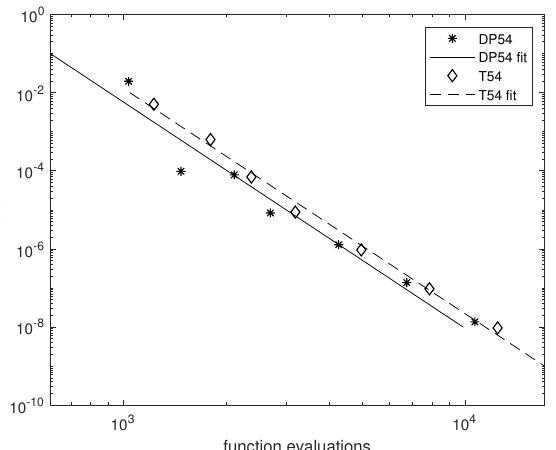
Figure 1. Results for DP5(4) and T5(4) as given in Tables 1 and 2 and their corresponding log- linear